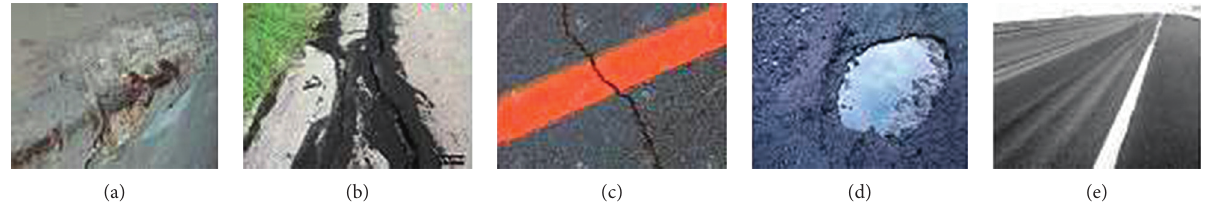
Figure 1: Sample images from the dataset: (a) bridge damage, (b) roadways cracks, (c) roadways lines, (d) roadways potholes, and (e) roadways rutting.